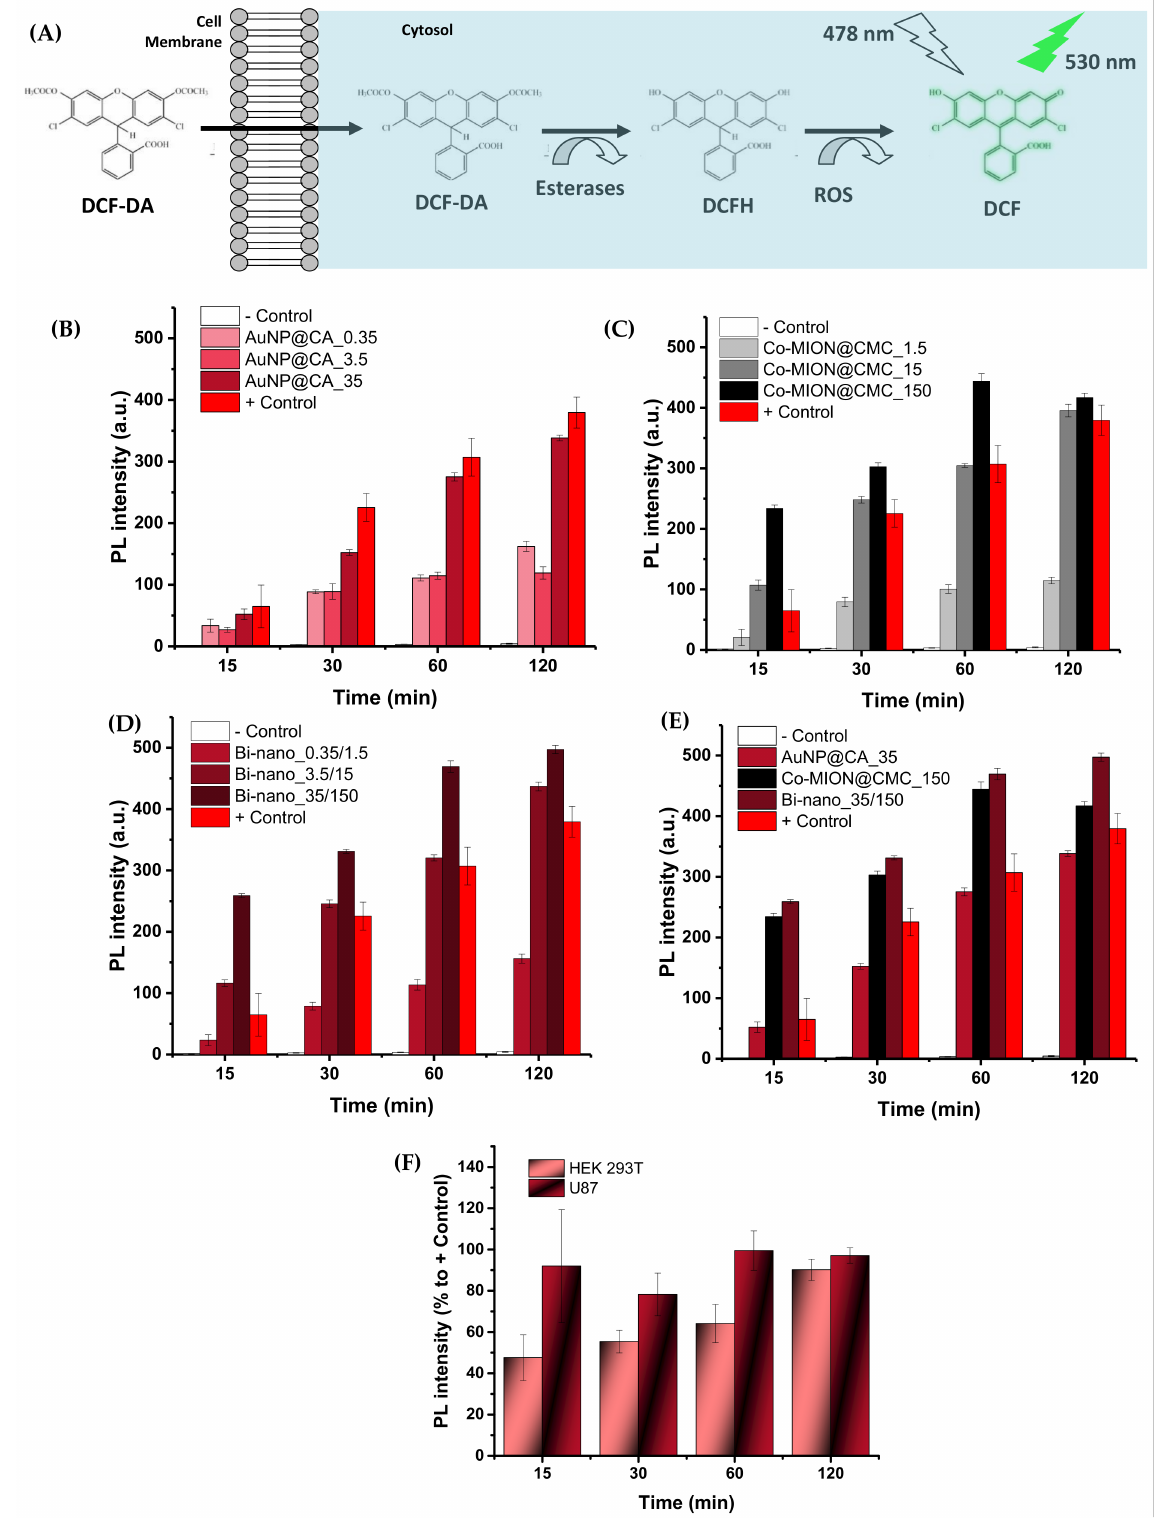
Figure 6. ( A ) Schematic representation of staining of ROS species with DCF-DA. PL intensity associated with the accumulation of intracellular ROS in the U87 MG cell line induced by ( B ) AuNPs, ( C ) Co-MION@CMC, and ( D ) the dual-nanozyme system after 15, 30, 60, and 120 min of exposure and at different concentrations. ( E ) Comparison of the PL intensity of the individual components and the dual-nanozyme system for the highest concentration of each nanozyme as the incubation time increased. ( F ) Effect of cell type measured for the dual-nanozyme system considering % to +Control (binanozyme concentration: 3.5 µ g/mL//15 µ g/mL,